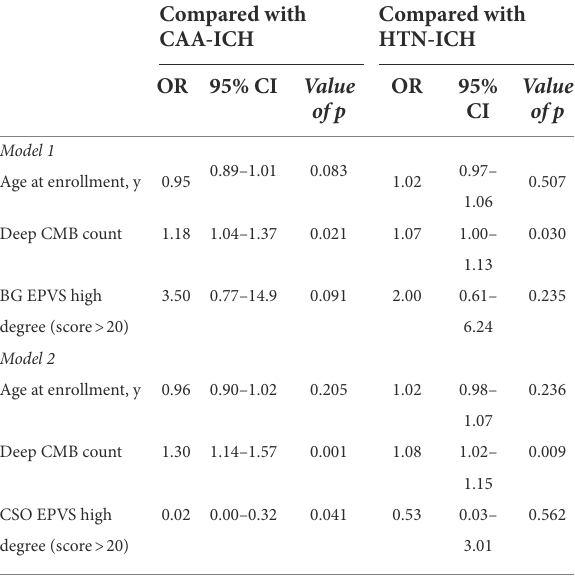
TABLE 3 Multivariable logistic regression models for factors associated with undetermined SMICH when compared with CAA-ICH and HTN-ICH.